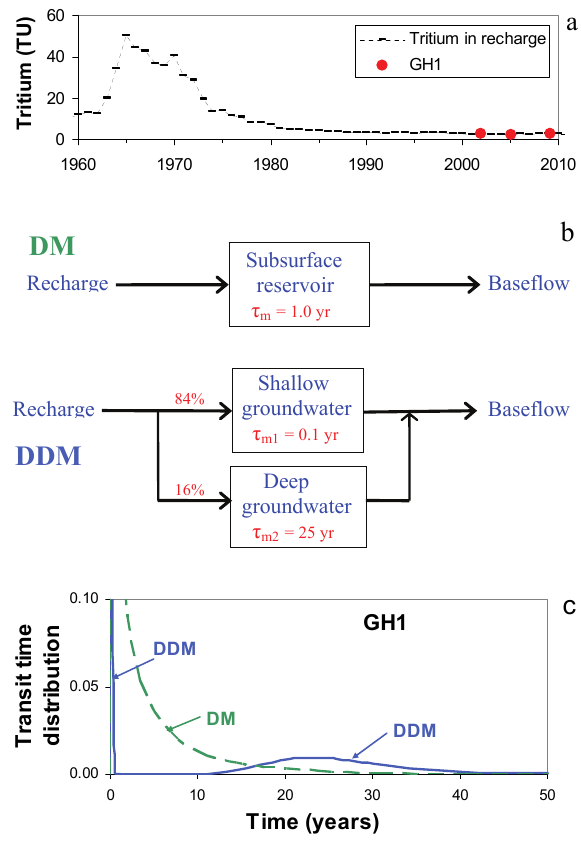
Fig. 4. (a) Tritium concentration in recharge for GH1. (b) Con- ceptualisation of baseflow using the DM and DDM models at GH1. (c) Best-fit transit time distributions with the DM and DDM models for